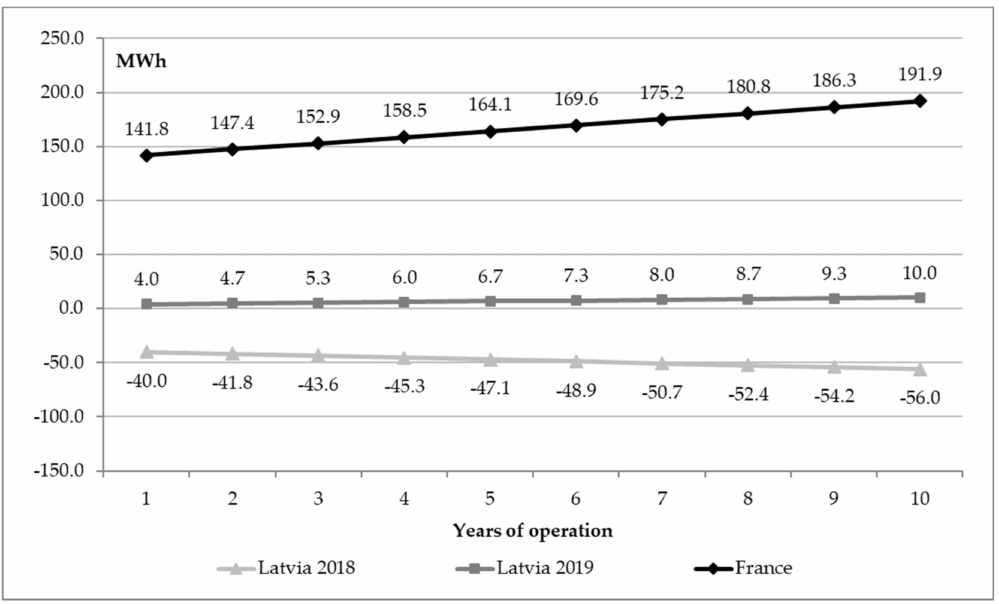
Figure 12. Annual electricity consumption for SOC renewal during the technical life of